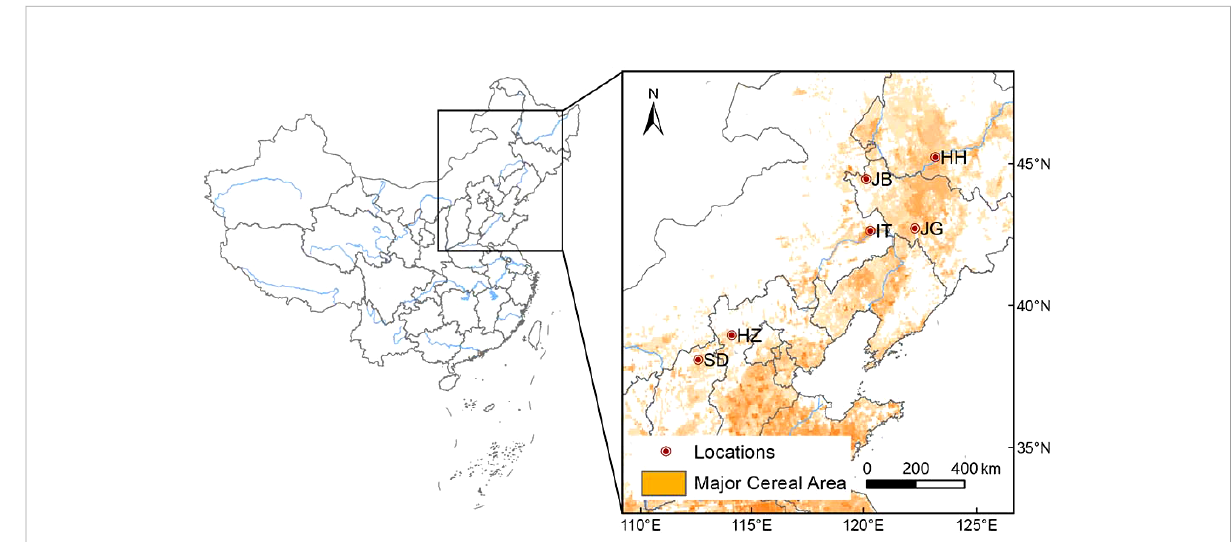
FIGURE 1 Locations of the study stations. HH, Harbin of Heilongjiang; JB, Baicheng of Jilin; JG, Gongzhuling of Jilin; IT, Tongliao of inner Mongolia; HZ, Zhangjiakou of Hebei; SD, Datong of